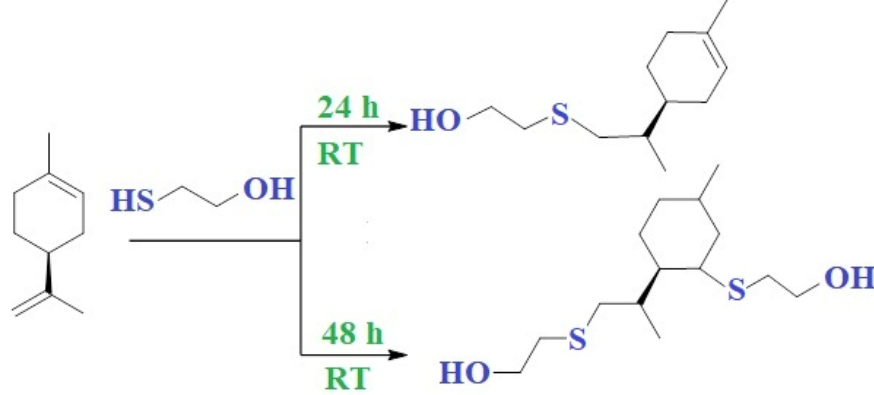
Figure 7. Reaction of 2-mercaptoethanol and limonene for 24 and 48 h at room temperature.